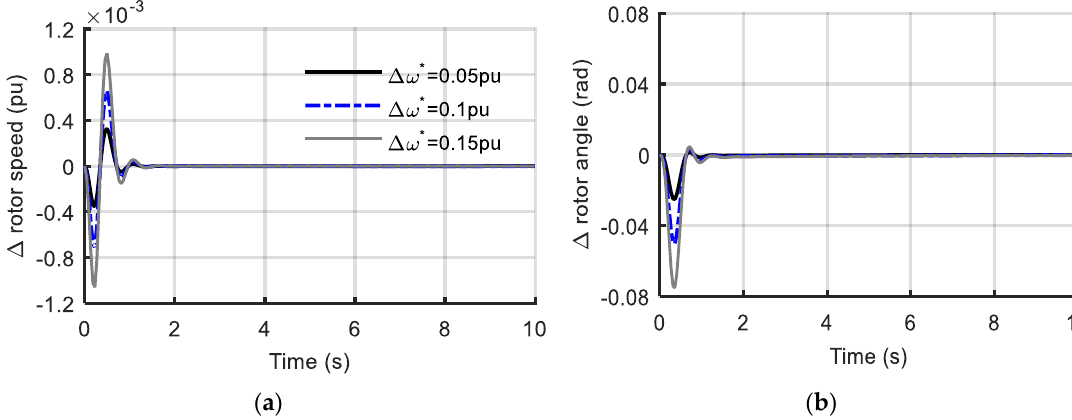
Figure 8. SG performance with considering wind speed impact at P = 1 pu, Q = 0.25 pu. ( a ) Rotor speed deviation; ( b ) rotor angle deviation.